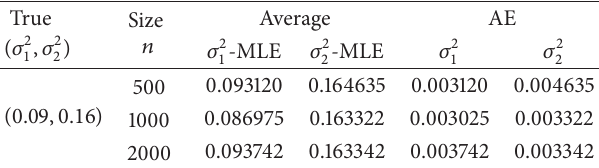
Table4:ThesimulationvaluesoftheMLEof (𝜎 2 1 , 𝜎 2 2 ) when Δ𝑡 = 0.1